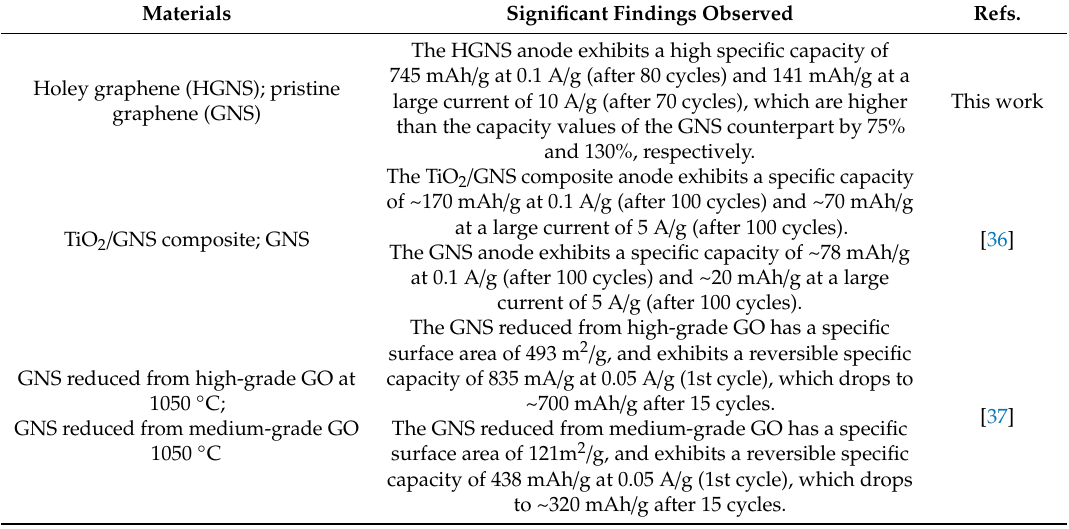
Table 4. Comparison of graphene anodes in lithium ion